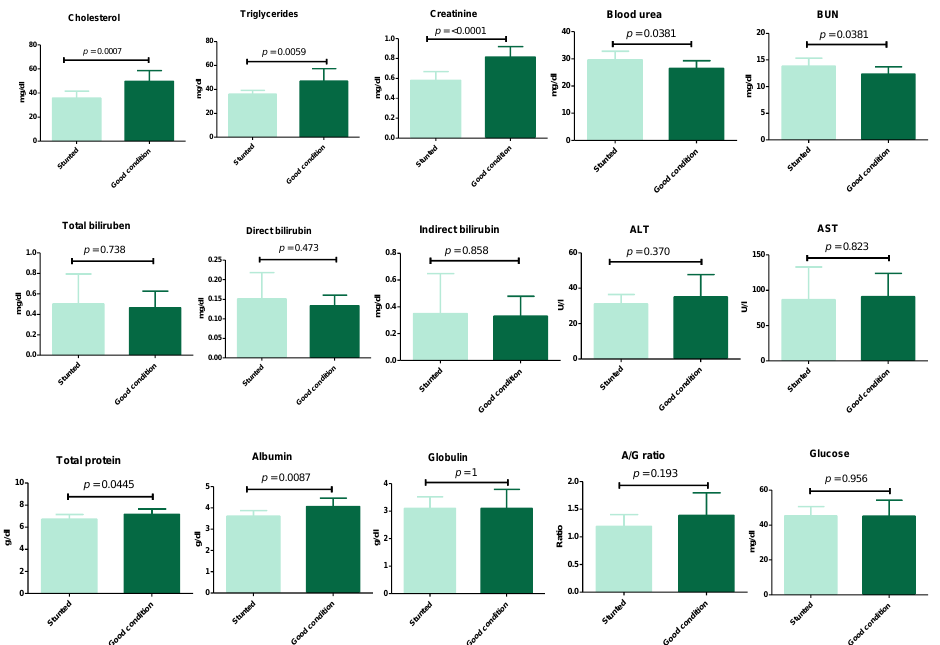
Figure 3. Biochemical analysis of Barki sheep serum. Values of various serum biochemical variables